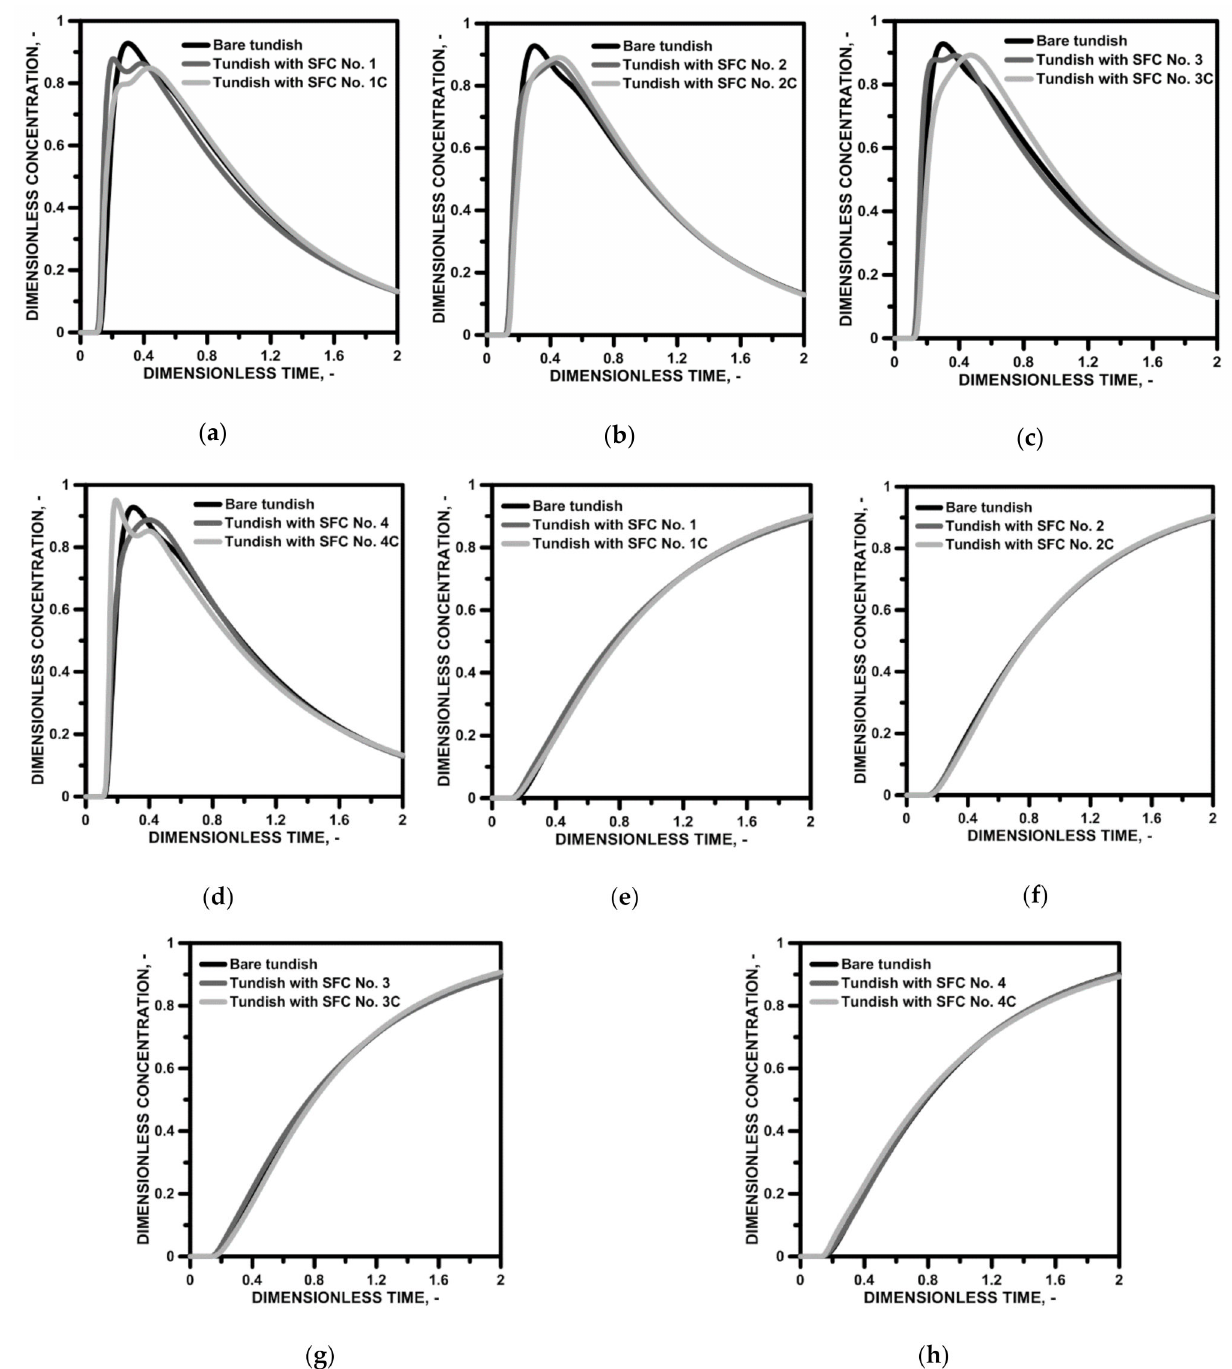
Figure 8. Residence time distribution curves for bare tundish and tundish with SFC: ( a ) E-type curves for SFC No. 1 and 1C, ( b ) E-type curves for SFC No. 2 and 2C, ( c ) E-type curves for SFC No. 3 and 3C, ( d ) E-type curves for SFC No. 4 and 4C, ( e ) F-type curves for SFC No. 1 and 1C, ( f ) F-type curves for SFC No. 2 and 2C, ( g ) F-type curves for SFC No. 3 and 3C, ( h ) F-type curves for SFC No. 4 and